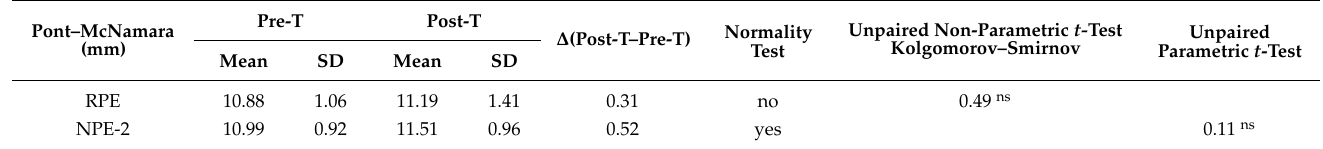
Table 4. Mean value of difference between posterior width according to Pont and posterior width according to McNamara.